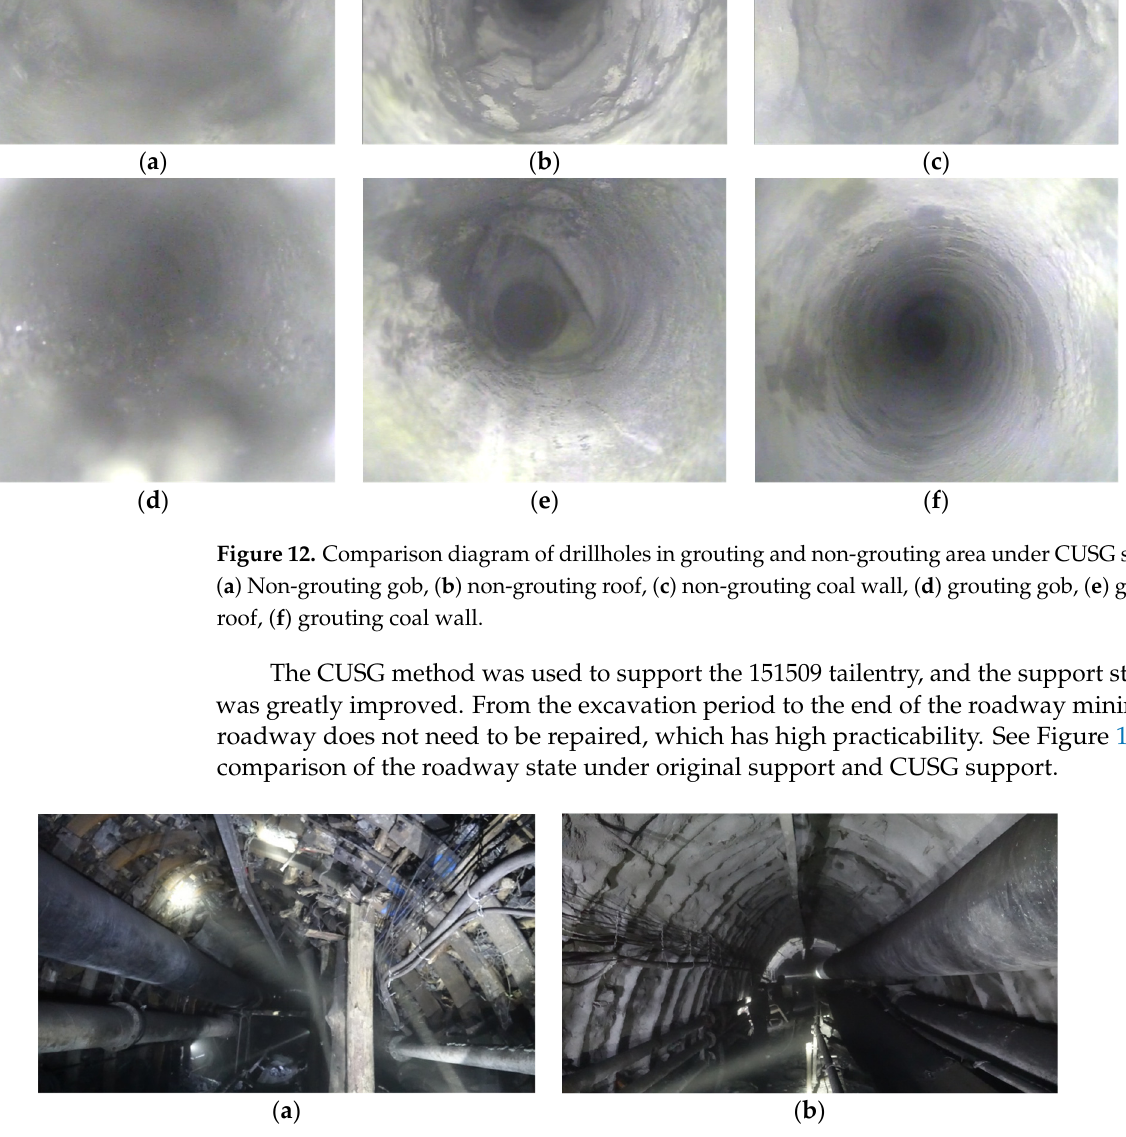
Figure 13. Roadway state before and after using CUSG support. ( a ) Primary support, ( b ) CUSG support.